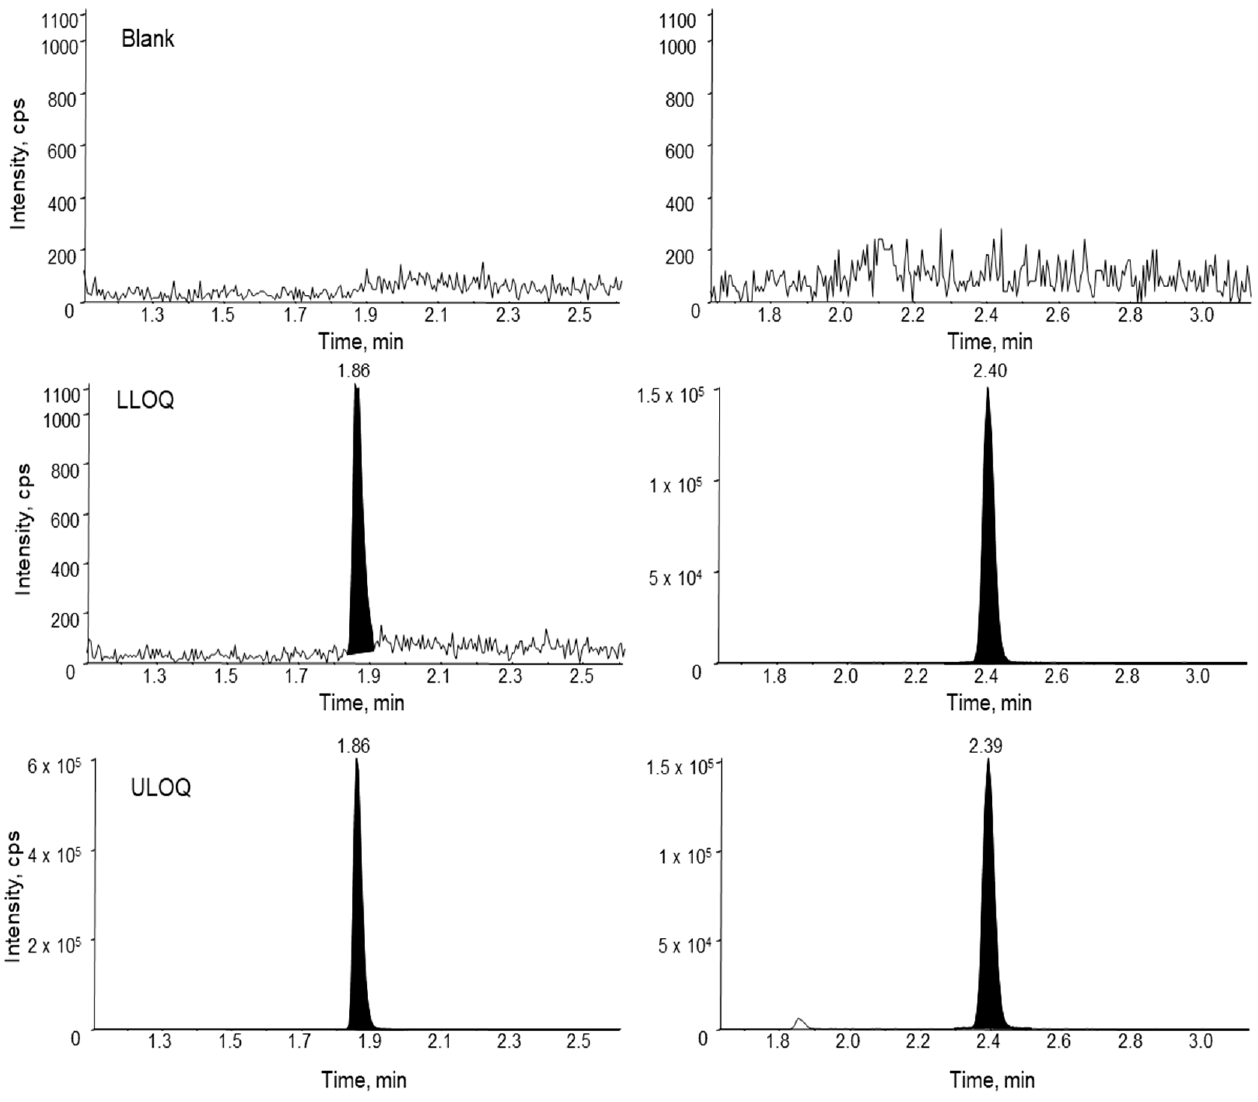
Figure 6. Representative MRM chromatograms of siRNA-01 ( left ) and the internal standard ASO-002 ( right ) in a blank monkey plasma, a monkey plasma spiked with the analyte at the LLOQ concentration (2.00 ng/mL), and ULOQ (1000 ng/mL) in monkey plasma.